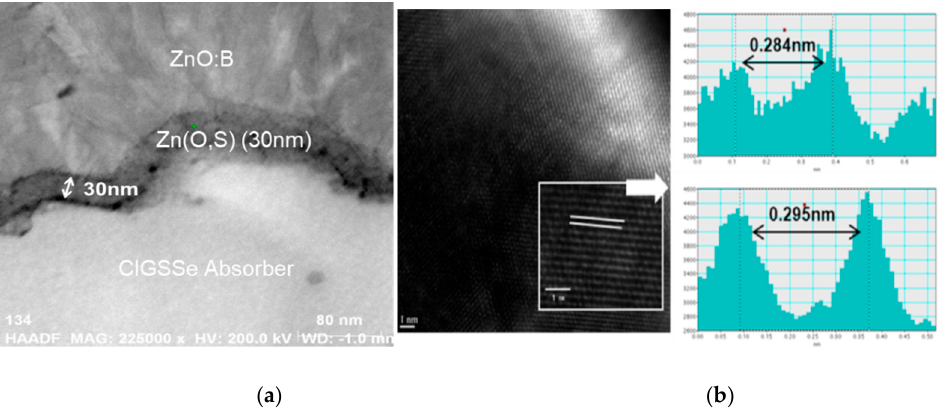
Table 1. Properties of Zn(O,S) films deposited with 100-cycle on SLG.